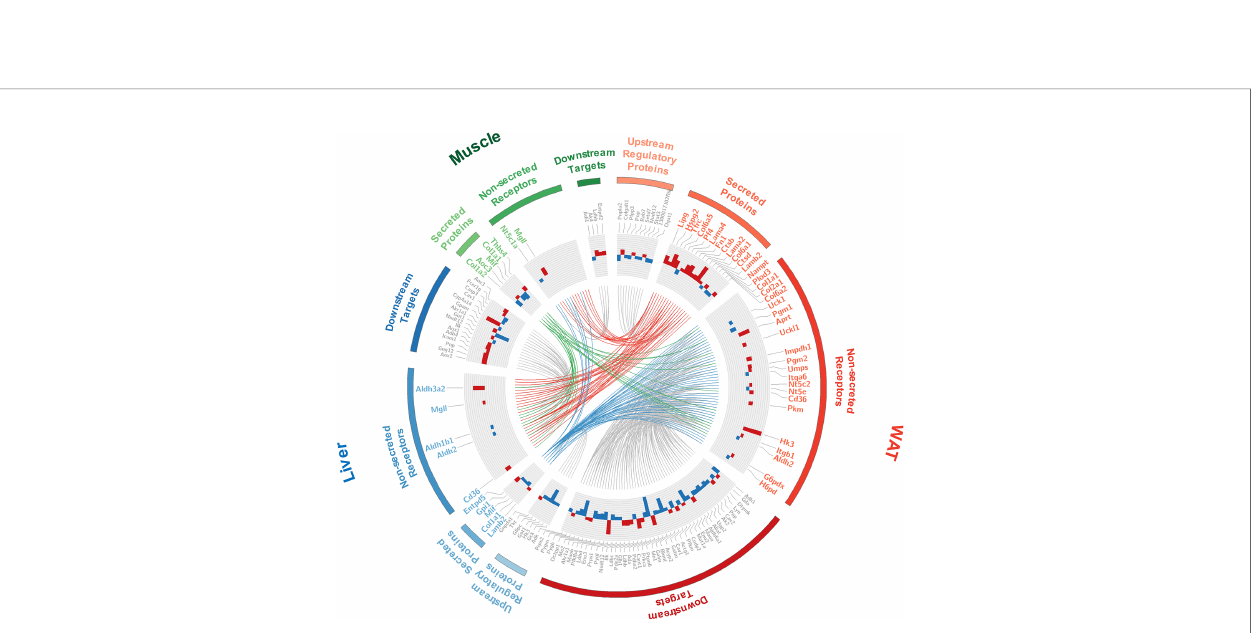
Frontiers in Endocrinology |